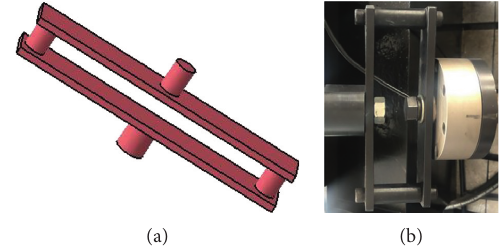
Figure 11: The structure of the damper. (a) The 3-dimensional model. (b) The prototype of the